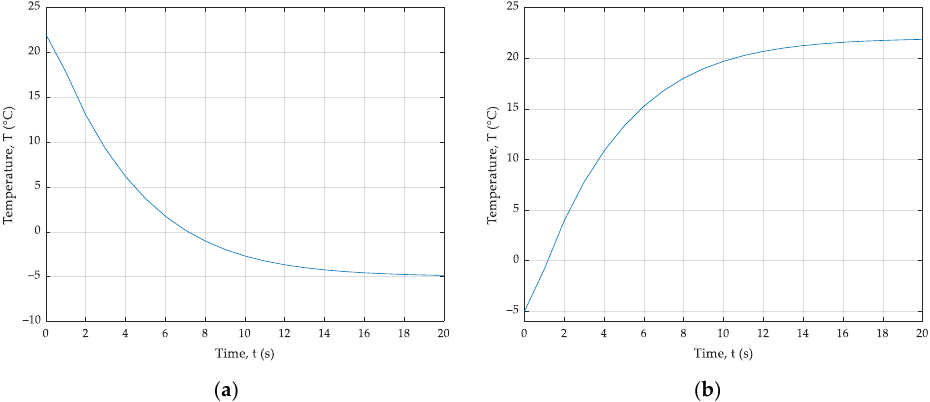
Figure 4. History of the temperature over time without using interval arithmetic: ( a ) from 22 °C to −5 °C and ( b ) from −5 °C to 22 °C.